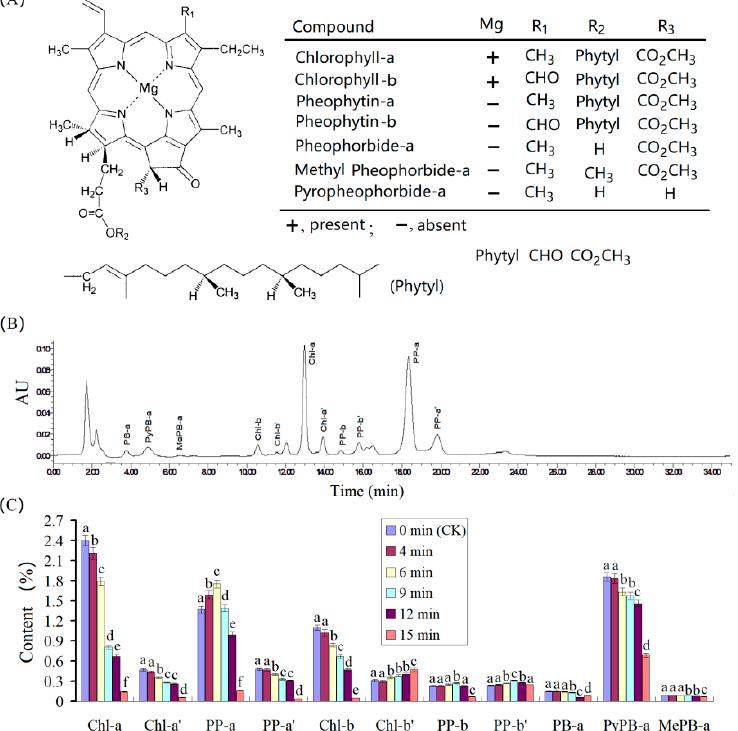
Figure 3. The chlorophylls and their derivates, and their change in green tea powder after microwave radiation of various times. ( A ) structures of chlorophylls and their derivates, ( B ) HPLC chromatogram of chlorophylls and their derivates in fresh green tea powder, and ( C ) change of chlorophylls and their derivates after microwave radiation; the different letters over the bars of a group indicate a significant difference ( p < 0.05).